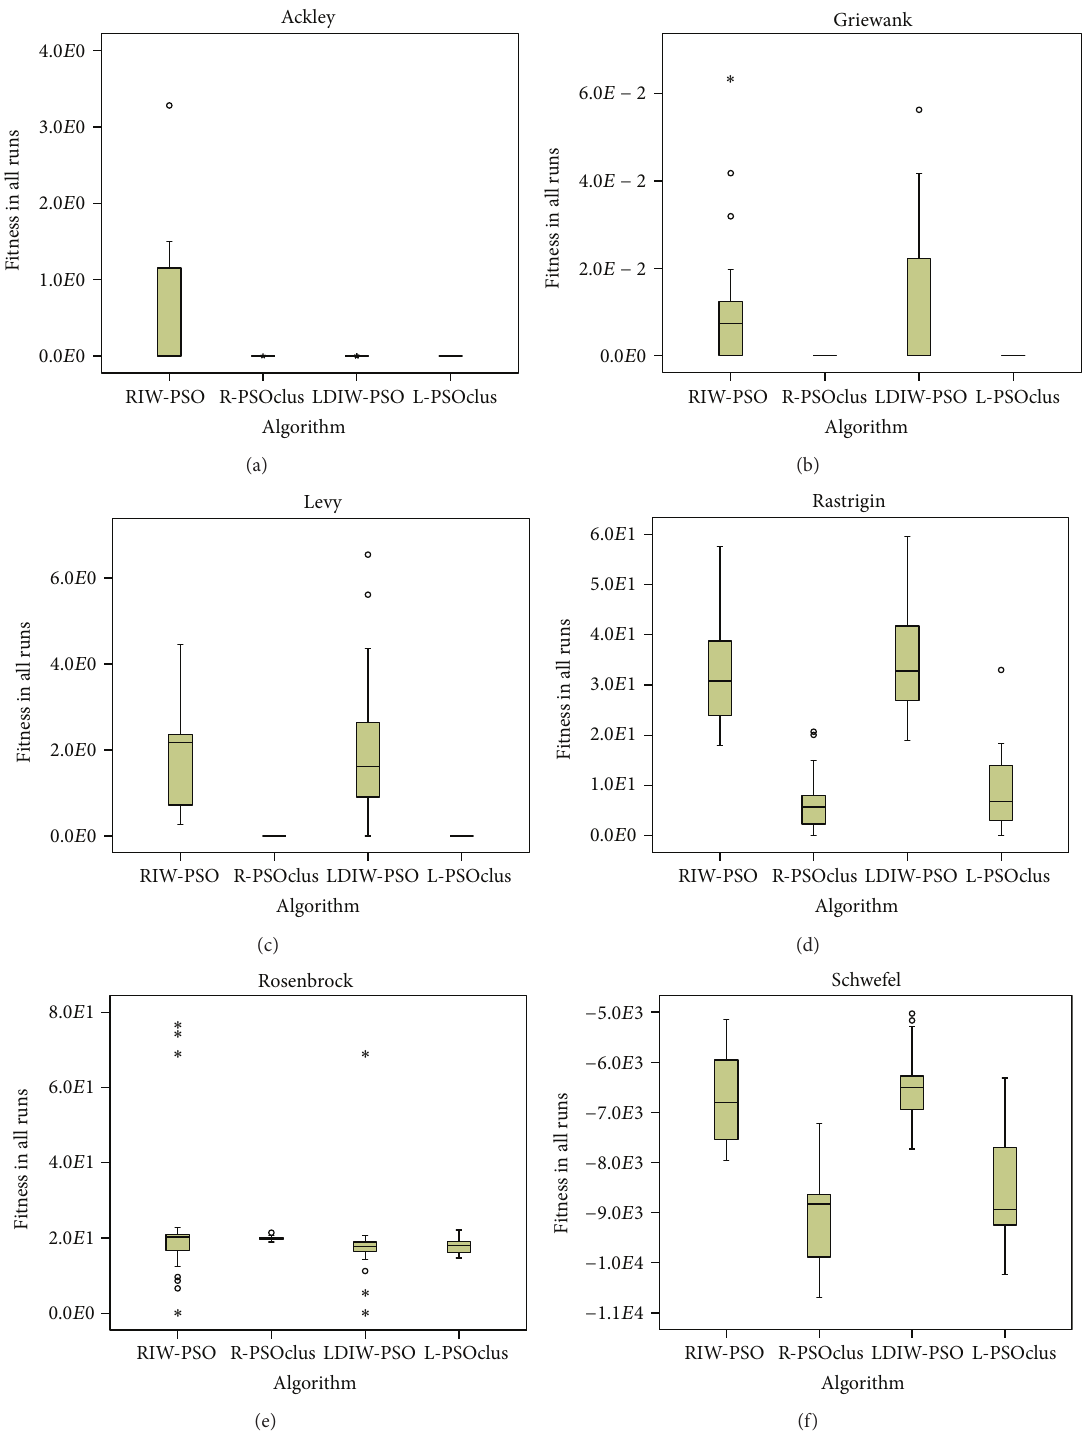
Figure 3: Box plots for 6 of the scaled test